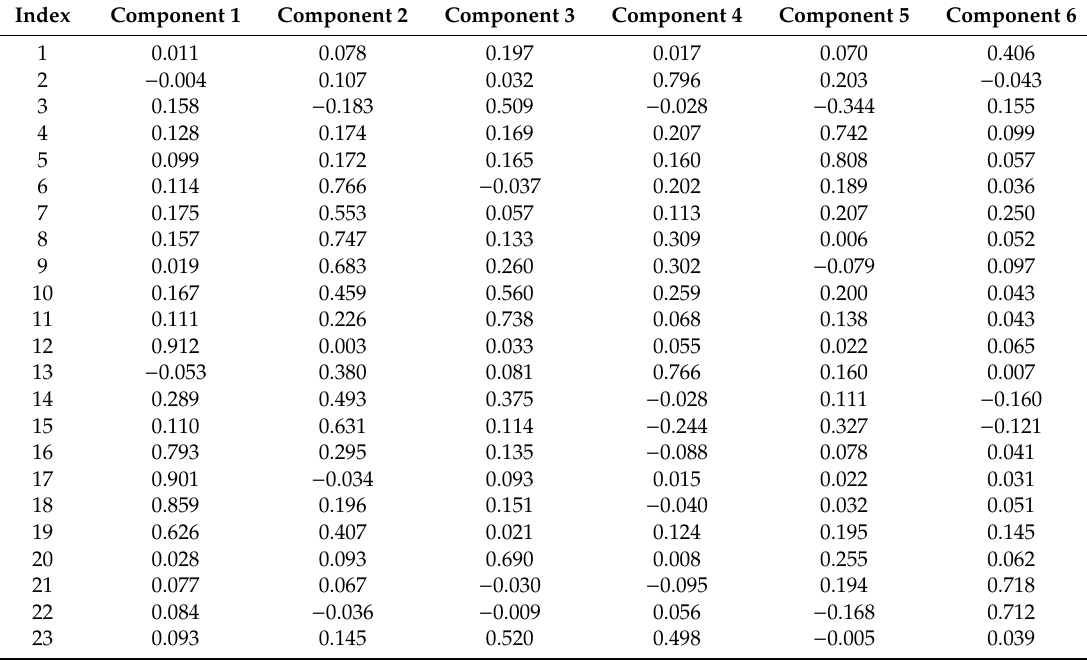
Table 7. Rotation component